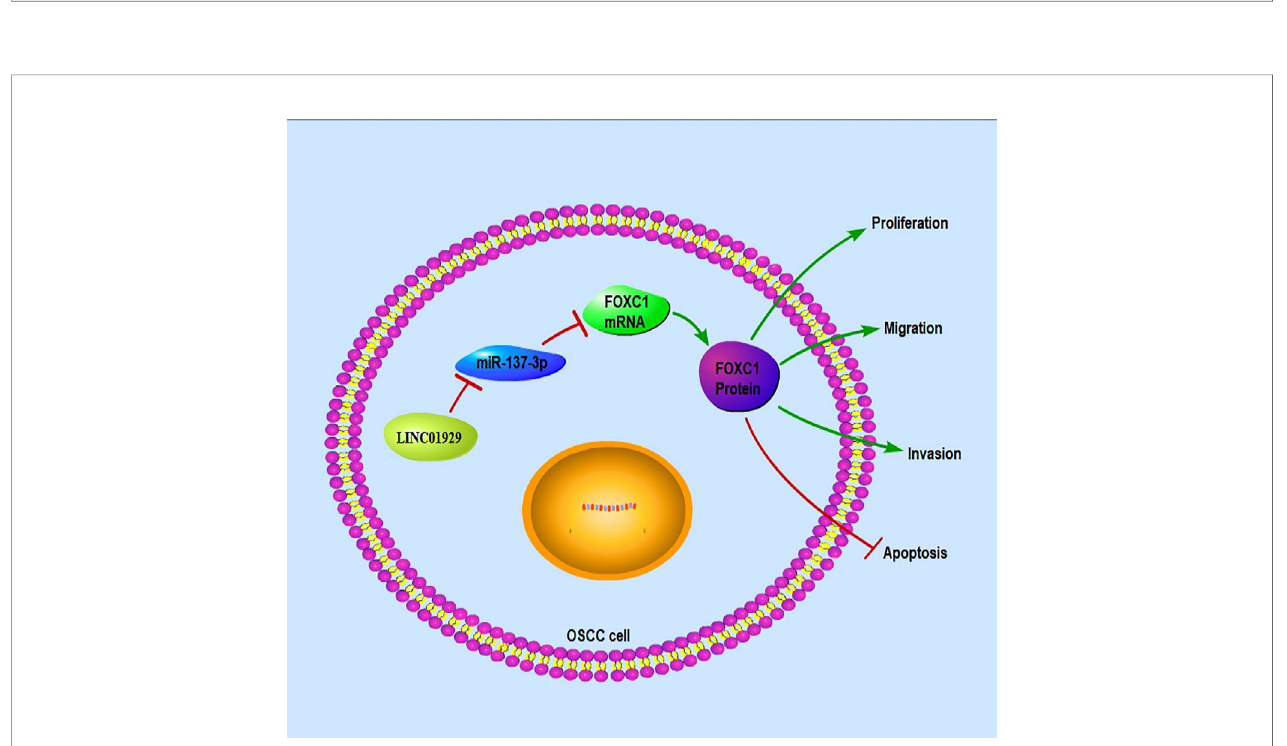
FIGURE 8 | Schematic of the LINC01929/miR-137-3p/FOXC1 axis in OSCC